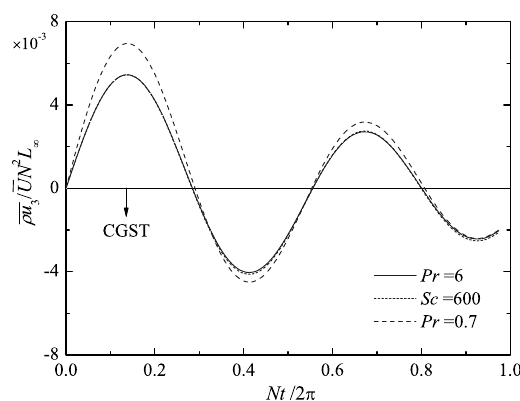
Fig. 2 Time variations of the vertical turbulent scalar flux in thermally stratified air (Pr = 0 . 7), thermally stratified water (Pr = 6), and salt-stratified liquid (Sc = 600) flows. The bulk Richardson number and Reynolds number are the same for all the